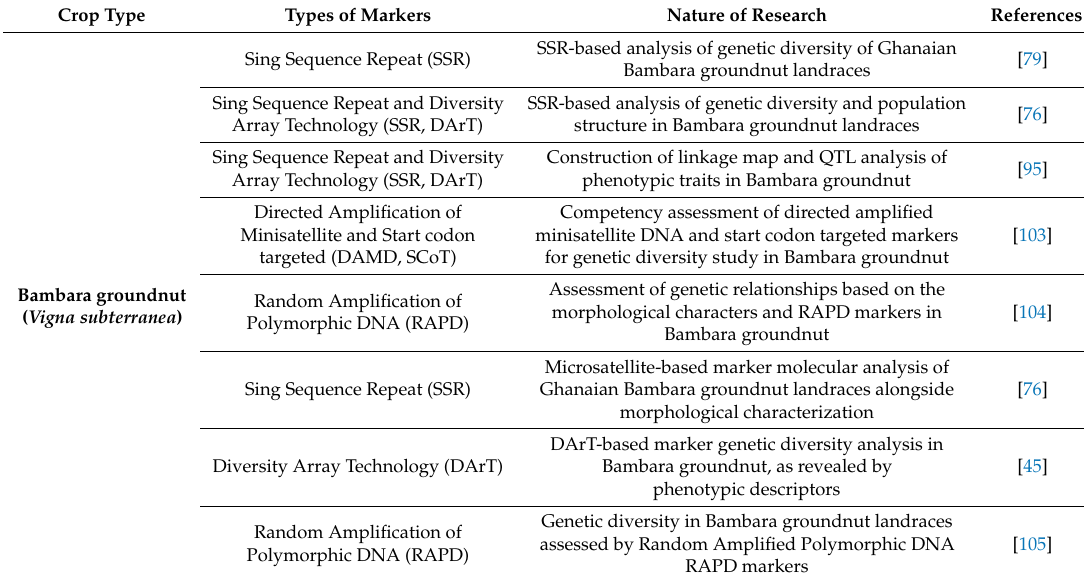
Table 3. Some reported molecular marker analyses of genetic diversity in Bambara